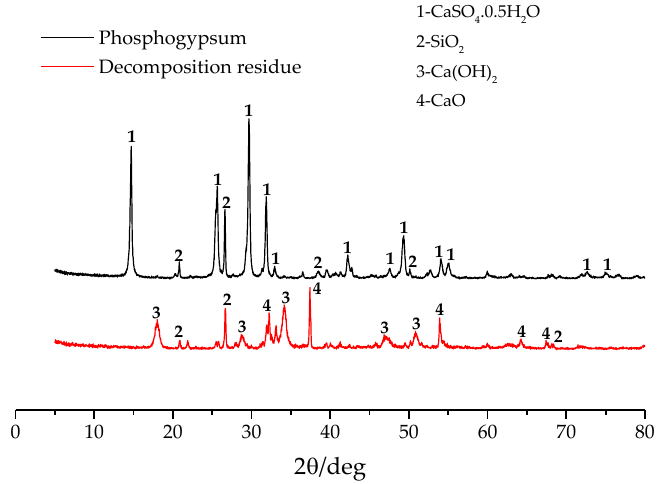
Figure 8. XRD of phosphogypsum decomposition residue.